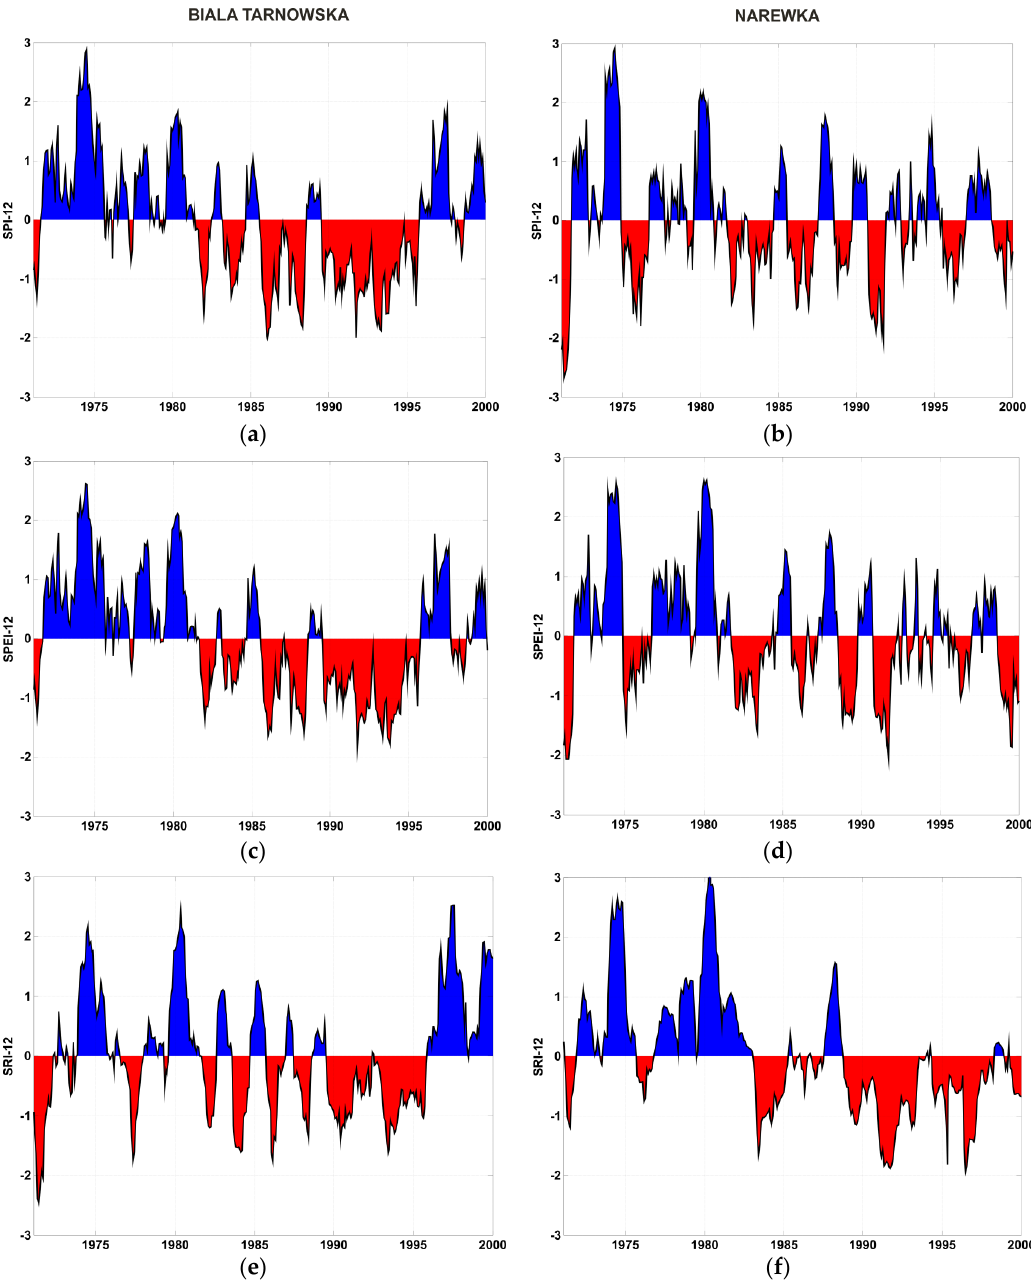
Figure 2. Comparison of the SPI-12, SPEI-12 and SRI-12 time series derived for Biała Tarnowska ( a , c , e ) and Narewka ( b , d , f ) catchments in the 1971–2000 period. The blue and red colours denote conditions, respectively, wetter or than a median from the 1971–2000 period.